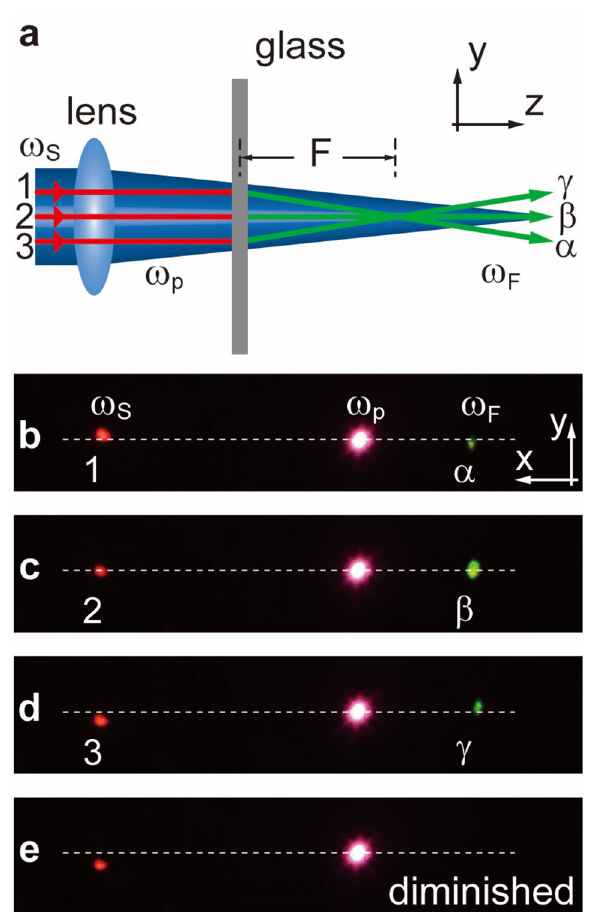
Figure 2. Nonlinear refractions across a focusing pump. By properly positioning the signal across different converging regimes of the pump in the flat slab, several nonlinear refraction relations of varying ϕ are shown in ( b – e ). F denotes the effective focal length for refracted FWM beam. ( a ) Experimental setup and analysis of FWM beams’ trend in the y ~ z plane. ( b – e ) Images on the target screen ( x–y plane) in the far field. Leftmost red spots: signal 1300 nm, centered red: pump 800 nm, rightmost green spots: FWM beam 578 nm. The horizontal dashed lines serve as references. The FWM spot is upshifted ( α to γ ) when moving the signal spot downwards from 1 to 3 . However, due to the limited phase-matching range, the FWM disappears in ( e